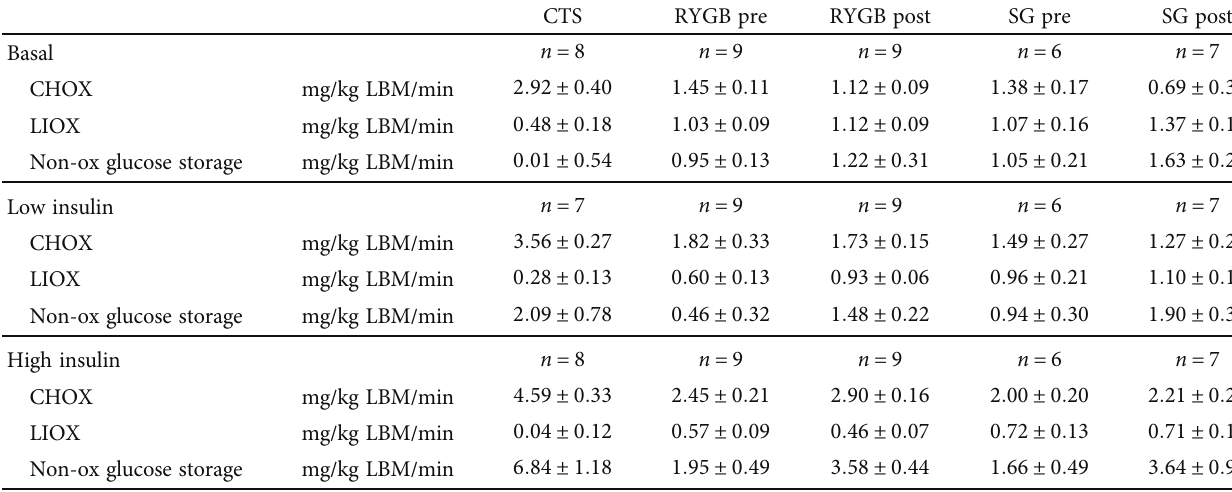
Table 2: Indirect